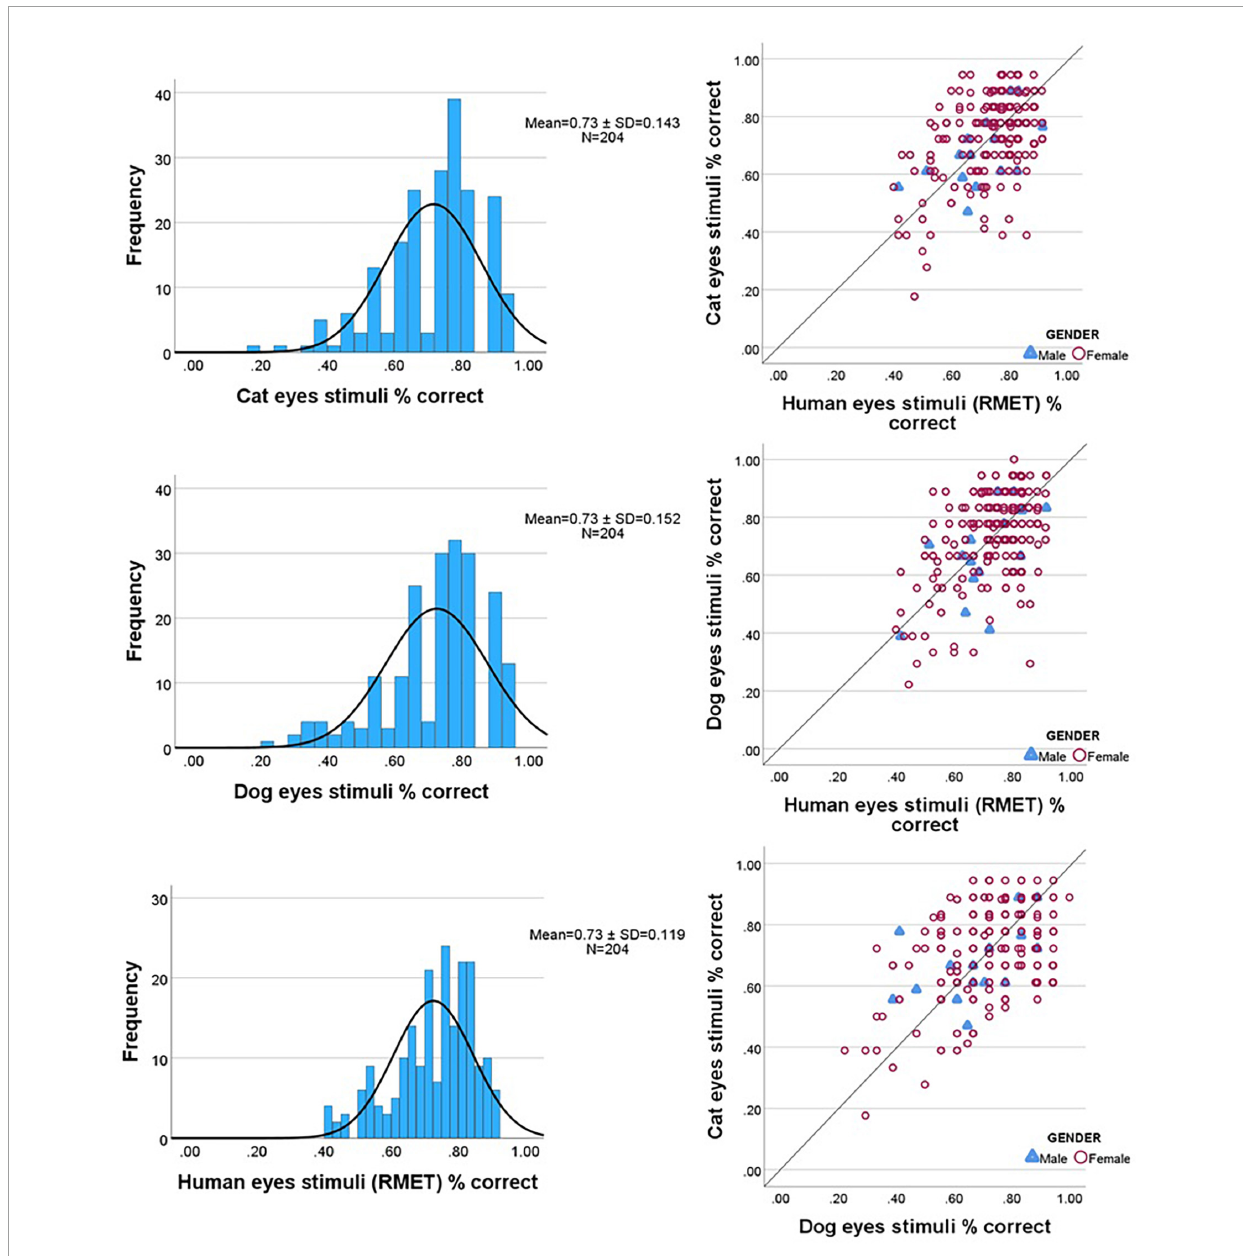
FIGURE1 Frequency distributions and correlation plots for eyes task stimuli